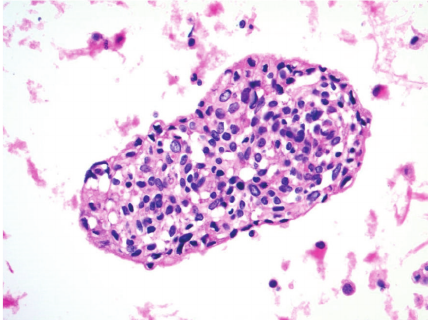
Figure 4: A cohesive and crowded group of metastatic DSRCT cells in pleural fluid with central epithelioid forms having minimal to moderate eosinophilic cytoplasm and open chromatin. Some cells at the tumor group margin have elongated/spindled morphologies with more dense chromatin (cell block, hematoxylin and eosin stain, 400x).